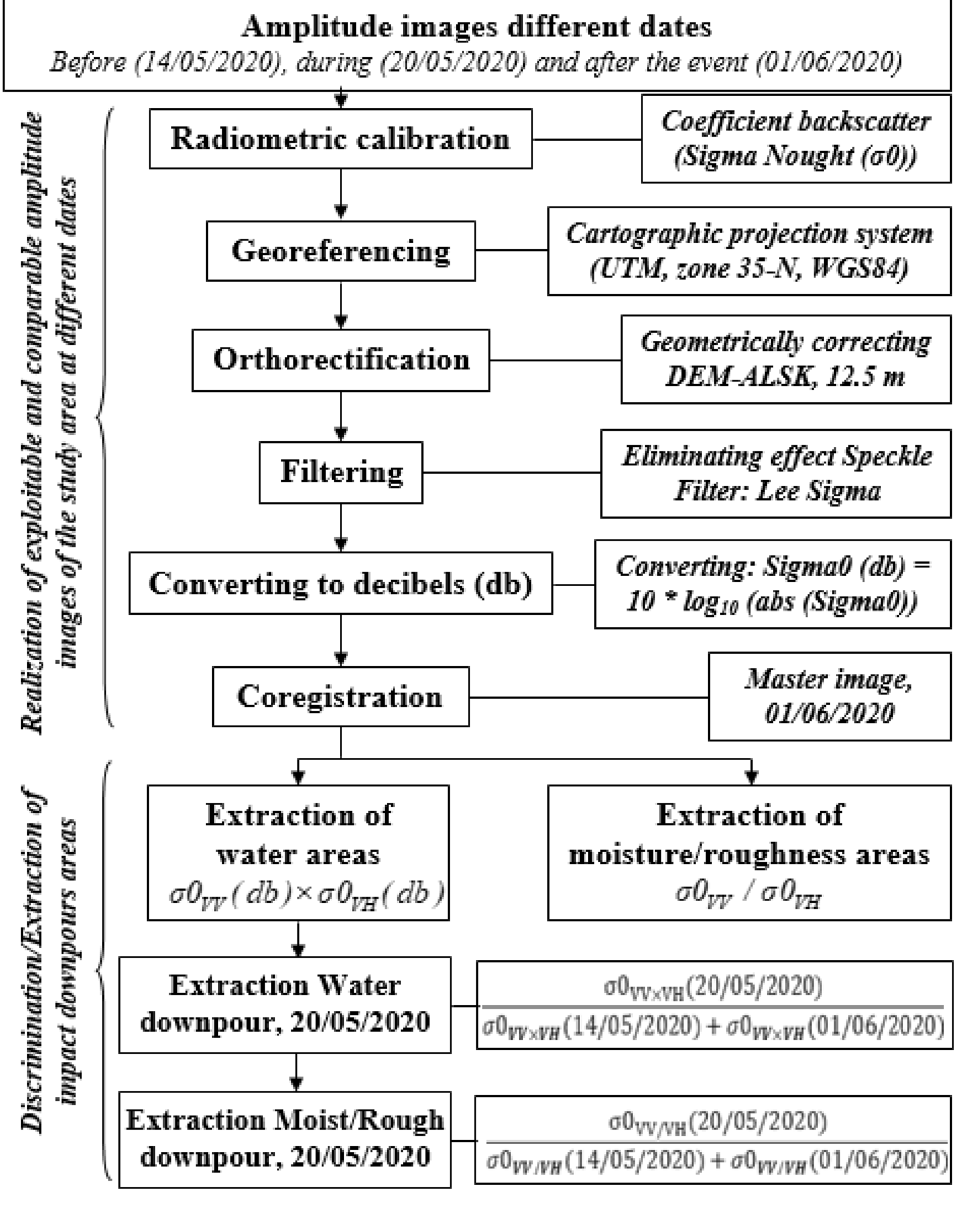
Figure 2. Flowchart showing the different steps of the performed